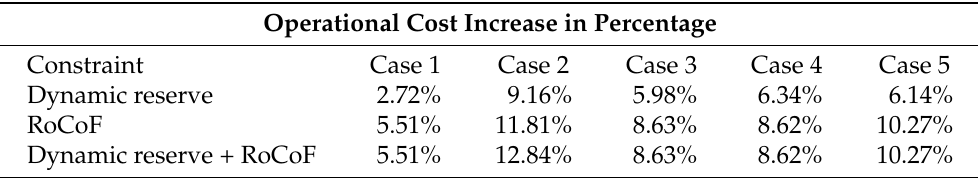
Table 6. Operational cost increase in percentage for the five cases and the three ways of constraint